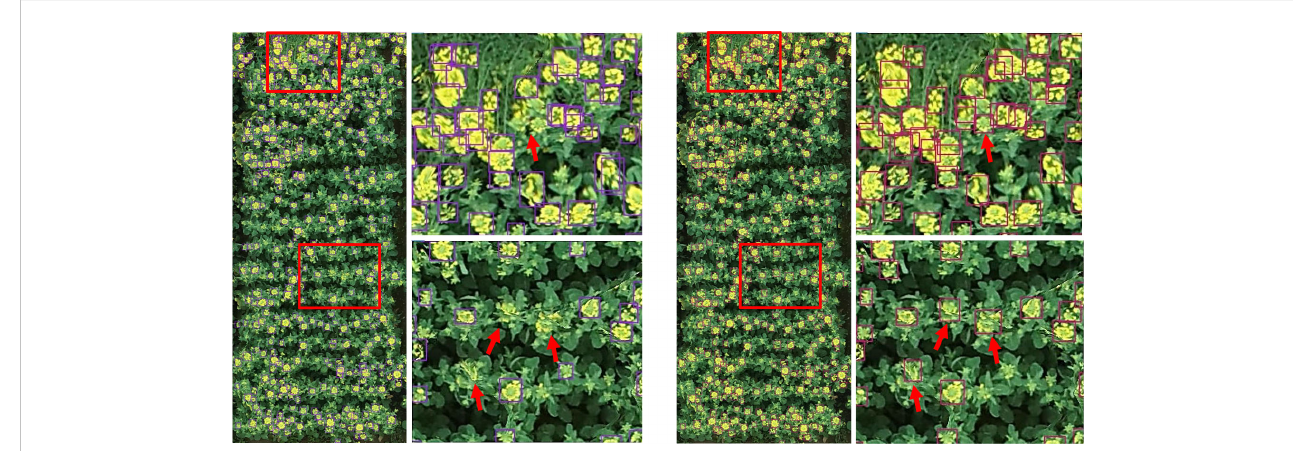
FIGURE 4 Comparison of detection results between YOLOv5x and YOLOv5x-CBAM. On the left is the YOLOv5x detection result and the partial enlarged view. On the right is the YOLOv5x-CBAM detection result and the partial enlarged